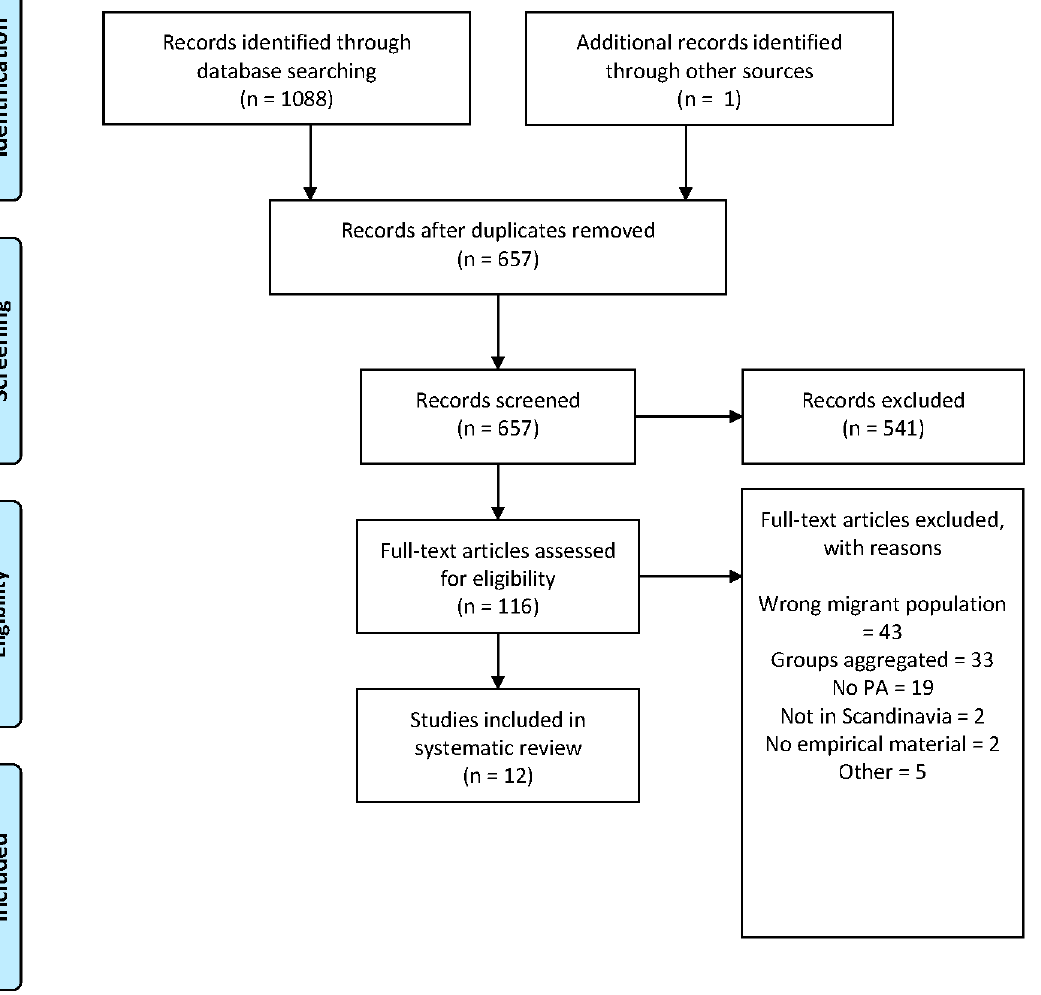
Figure 1. Flow chart of inclusion and exclusion of articles.